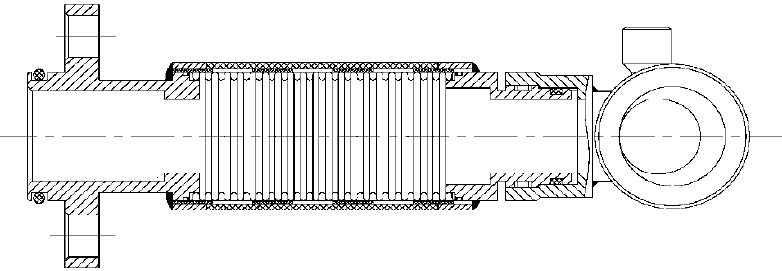
Figure 4. The structure diagram of rubber pipe (RP).